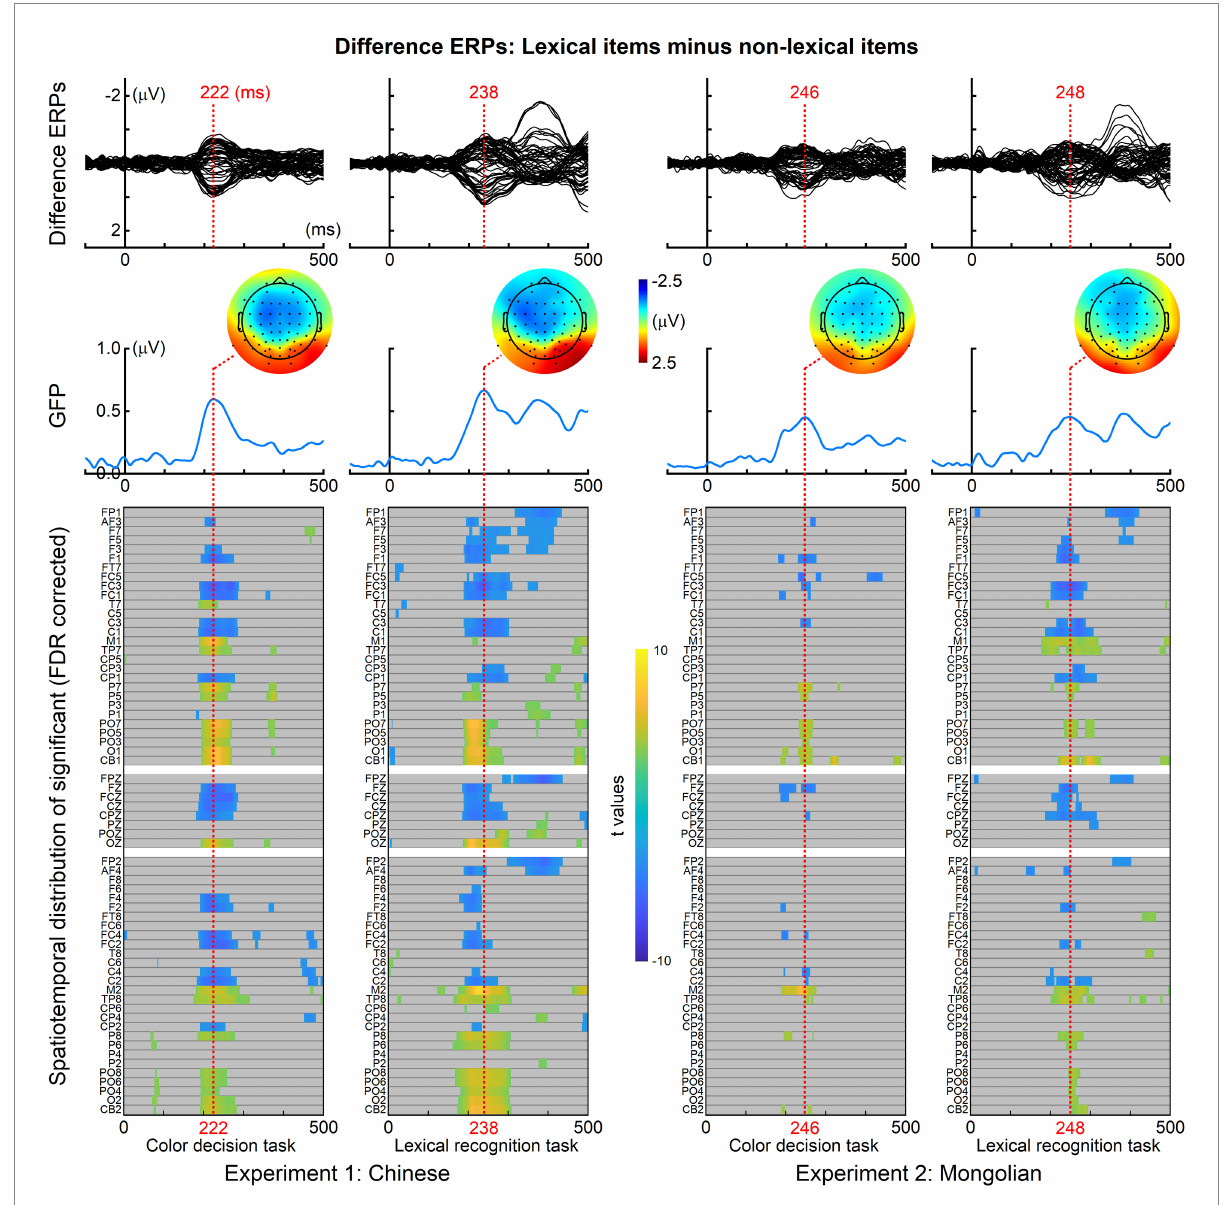
FIGURE 4 Event-related potentials differences between lexical and non-lexical items. For both tasks and both experiments, significant differences between the ERPs of lexical items and the ERPs of non-lexical items were observed at approximately 200–250 ms (highlighted by red dotted lines). The difference ERPs was obtained by subtracting the ERPs of non-lexical items from the ERPs of lexical items. The global field power (GFP) of the difference ERPs, and the topographic maps at the GFP peaks are